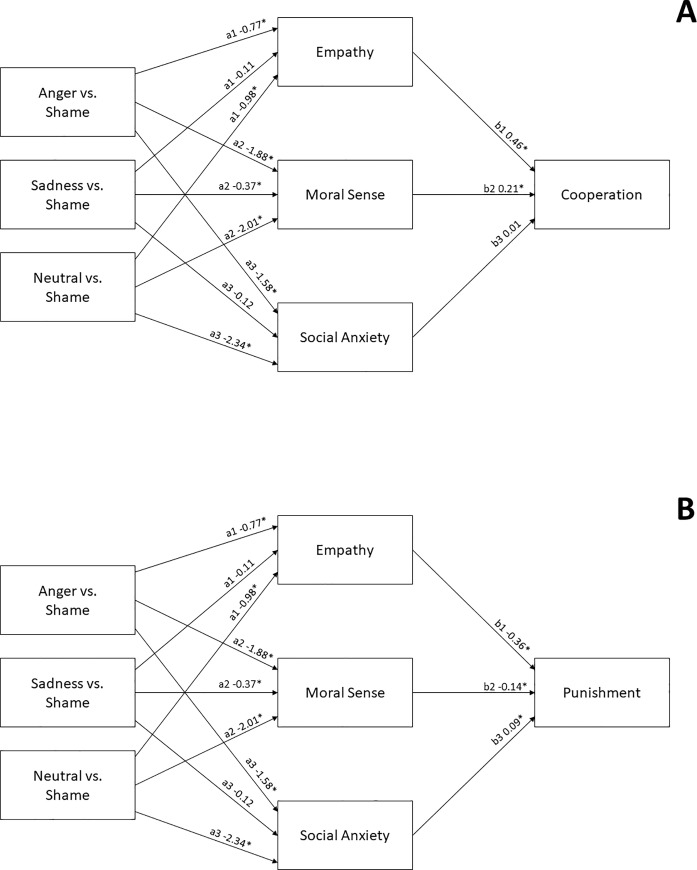
Regression model of emotional expressions’ effect on mediators and mediators’ relation to cooperation and punishment ratings.Coefficients are unstandardized regression coefficients, emotional expressions were contrasted with shame when comparing independent to mediator, and severity of transgression was used as a covariate. A’s refer to emotional expressions' influence on mediators and b’s to mediators’ effect on cooperation and punishment when all the other mediators in the model are controlled for. For the complete output of the regression results see S4 Appendix.